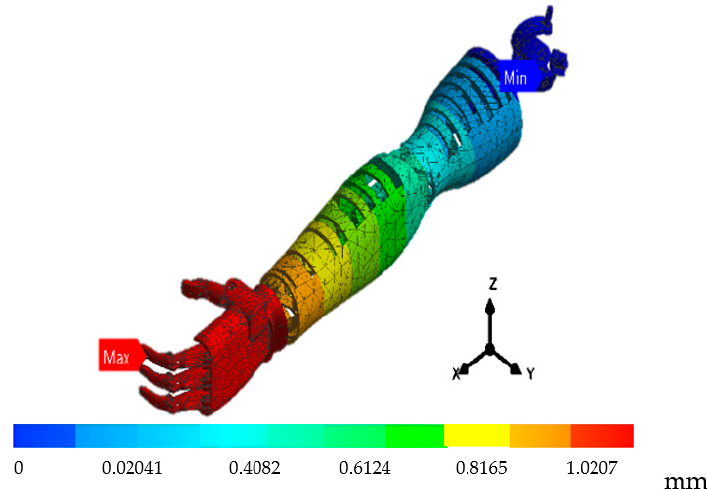
Figure 5. The total displacement, material aluminum 7075-O.